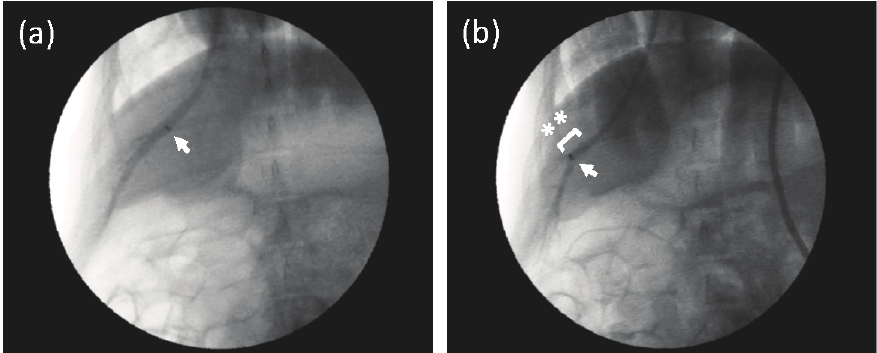
Figure 1. Venography of the hepatic vein (HV) in the right medial lobe. ( a ) A